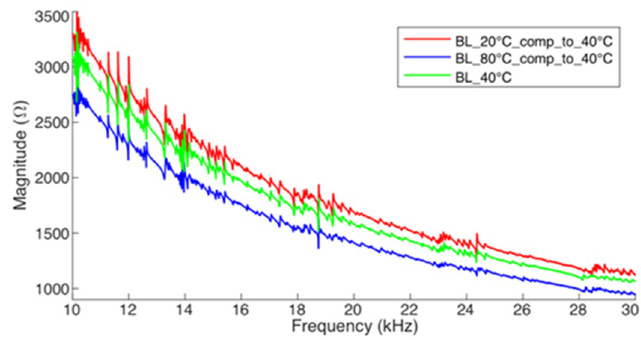
Figure 15. Horizontal compensation for pipe-1/PZT-1 (Experiment).